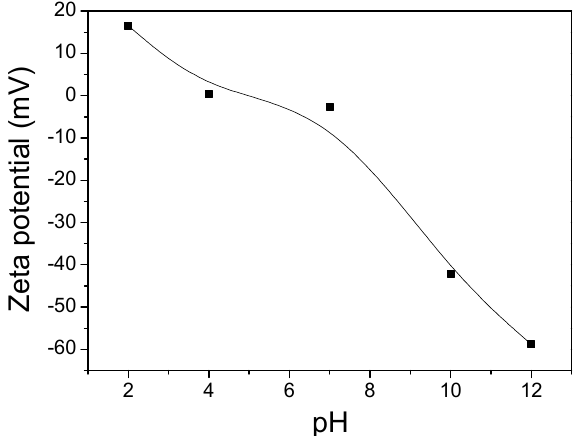
Figure 3. Zeta potential of BCS_650 as a function of pH.